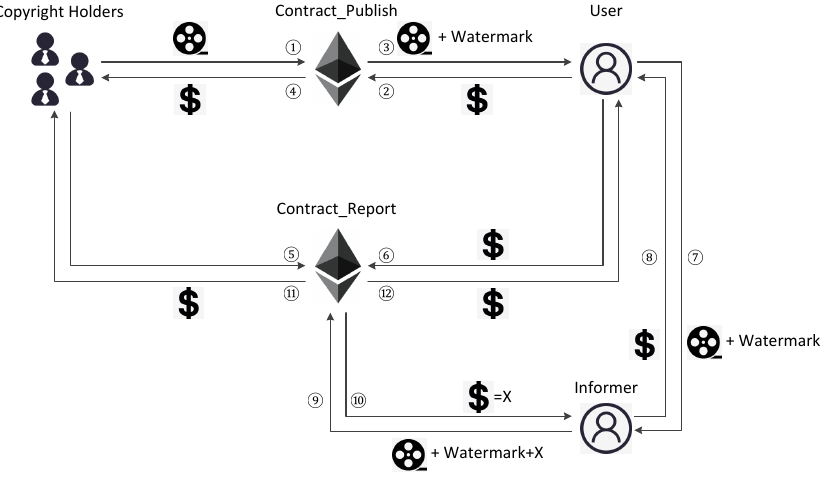
Figure 4. Process of interaction of